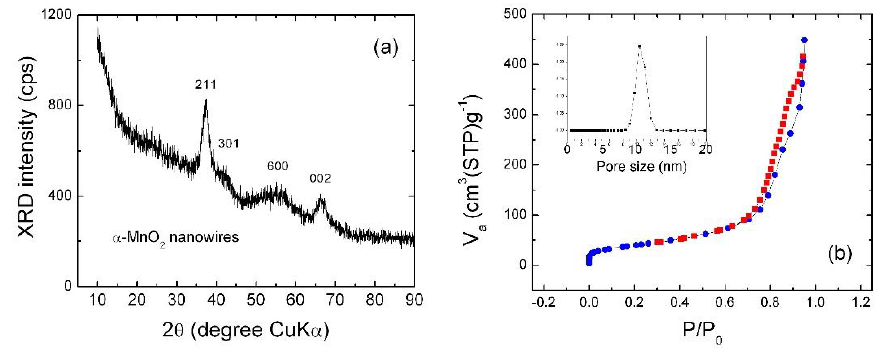
Figure 3. ( a ) XRD patterns of α-K y MnO 2 nanoneedles. ( b ) N 2 adsorption-desorption isotherm of α-K y MnO 2 nanoneedles and the pore size distribution (inset).